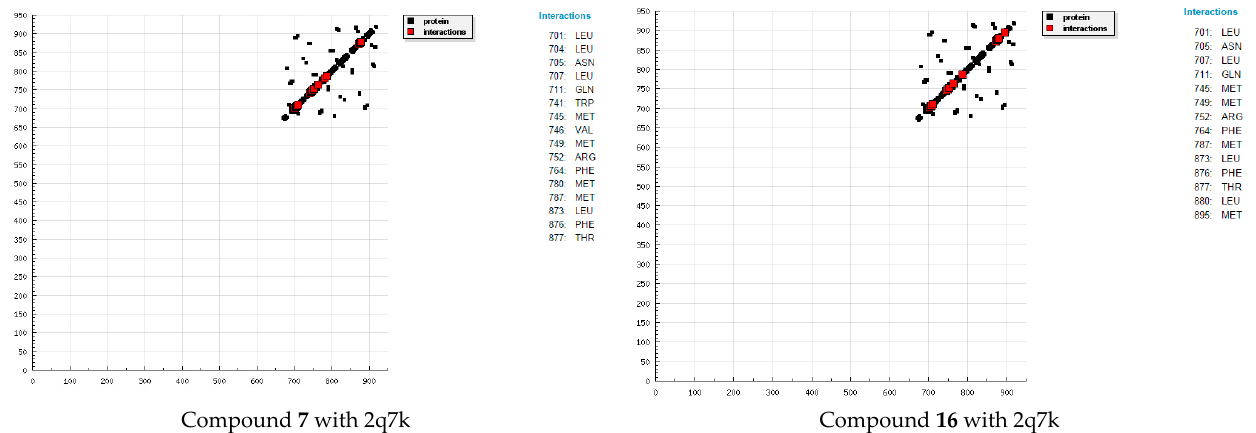
Figure 3. HB plots of interaction between some synthesized compounds and prostate cancer 2q7k hormone.